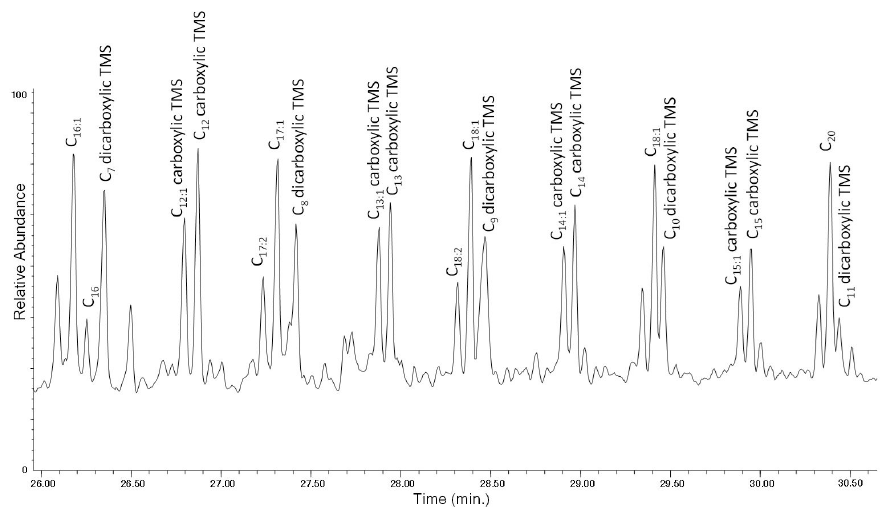
Figure 15. Chromatogram obtained (26.00–30.50 min) in the Py(HMDS)–GC–MS analysis of the DCM extract of LDPE-4w. C n:2 refers to α , ω -dienes, C n:1 to 1-alkenes, and C n to alkanes of a given C n hydrocarbon.